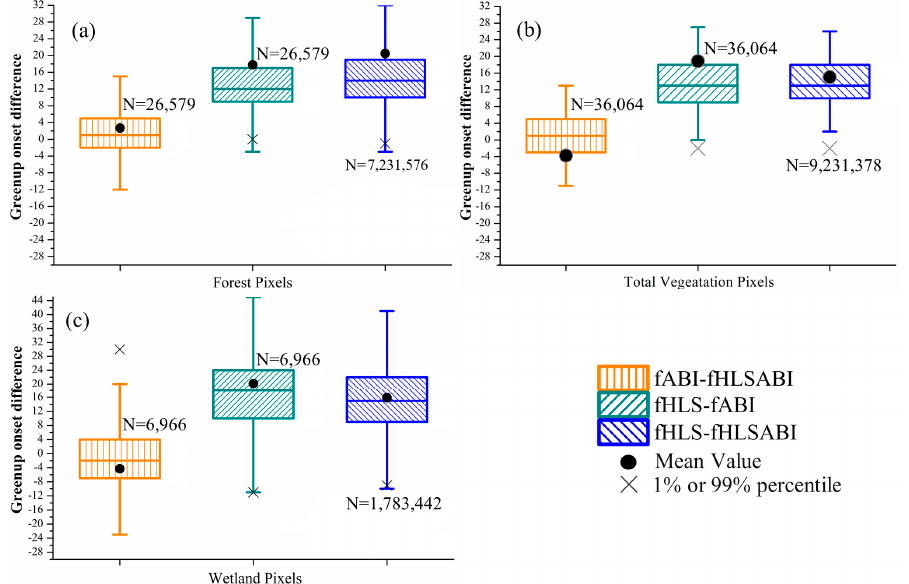
Figure 7. Boxplots showing the difference of greenup onset detected from three time series in ( a ) forest pixels, ( b ) all vegetation pixels, and ( c ) wetland pixels, respectively. The fABI, fHLS, and fHLSABI represent phenological timings from ABI, HLS, and HLS-ABI data, respectively. Black dots denote the mean difference, while black crosses denote either the %1 or 99% percentile of differences. Black crosses that out of the Y-axis range are not displayed. Note that 30 m HLS and HLS-ABI data were aggregated to 500 m for the comparison.